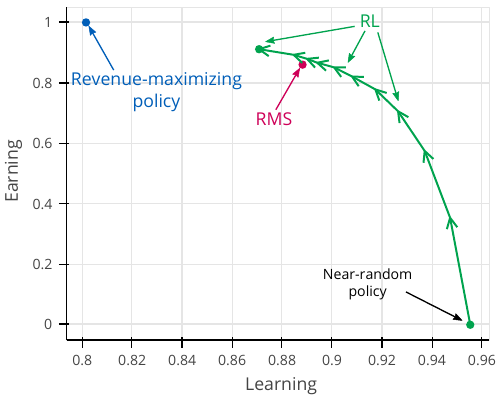
Figure 11. RL trajectory in the earning–learning space. The earning axis represents the average normalized revenue for the evaluation interval, while the learning axis represents the average || ψ − ψ ∗ || estimated demand parameter’s accuracy 1 − . The revenue-maximizing policy is obtained by || ψ ∗ || providing the true demand behavior parameters to the optimizer while keeping the estimation of parameters of the demand model as usual. The balance found by the revenue-maximizing policy is unstable, thus not being an answer to the